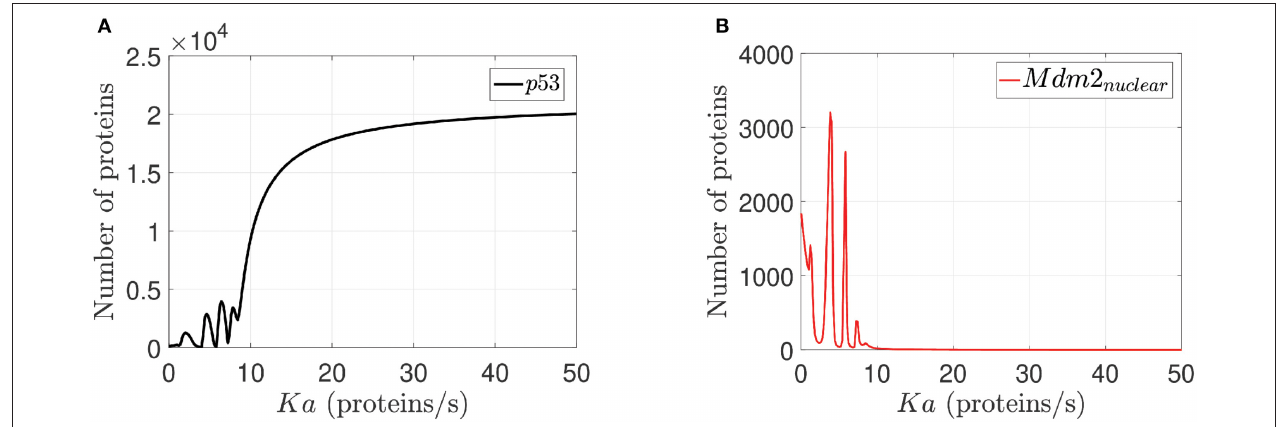
FIGURE 5 | Sensitivity analysis for K a . In (A) p53 response to K a variations is illustrated. In (B) Mdm2 nuclear response to K a variations is presented. For both cases K a varies between 0 to 50 proteins / s for all network proteins, but we select p53 and Mdm2 nuclear because they are the output desired in the network.